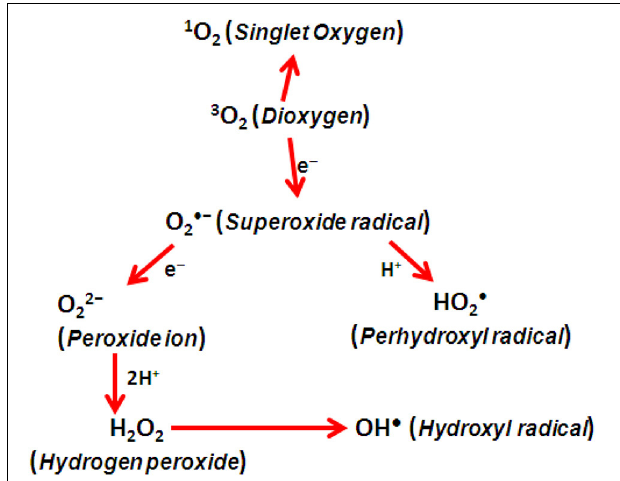
FIGURE 2 | Generation of ROS by energy